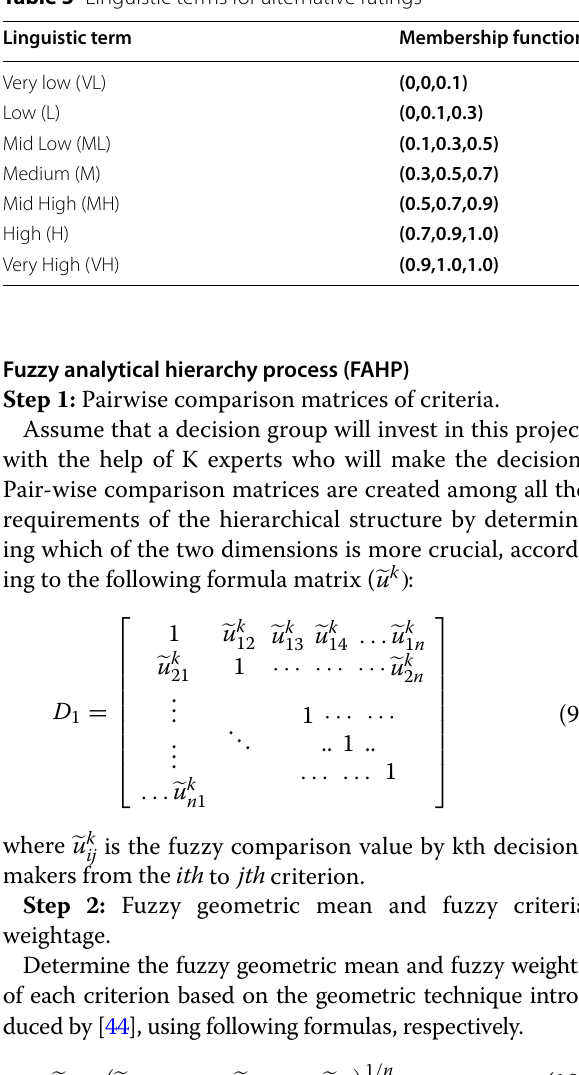
Table 3 Linguistic terms for alternative